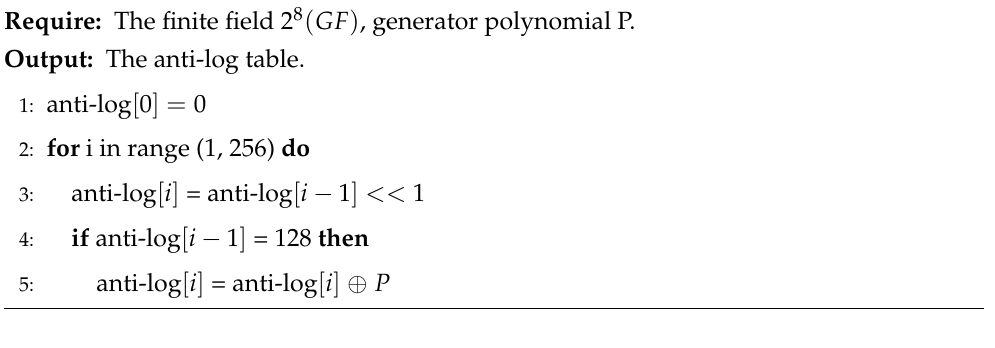
Algorithm 1 2 8 ( GF ) anti-log table generation.